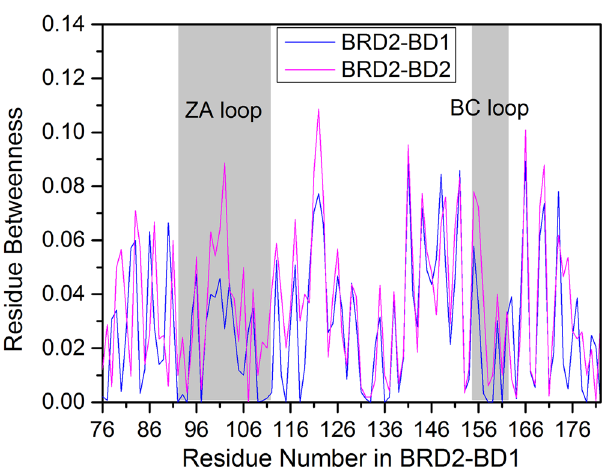
Figure 7. Residue betweenness as a function of residues in holo systems of BRD2-BD1 and BRD2-BD2. To exhibit betweenness difference of two systems clearly, residue number used in BRD2-BD2 system is corresponding to that of RCSB Protein Data Bank (PDB ID: 4MR4) in BRD2-BD1